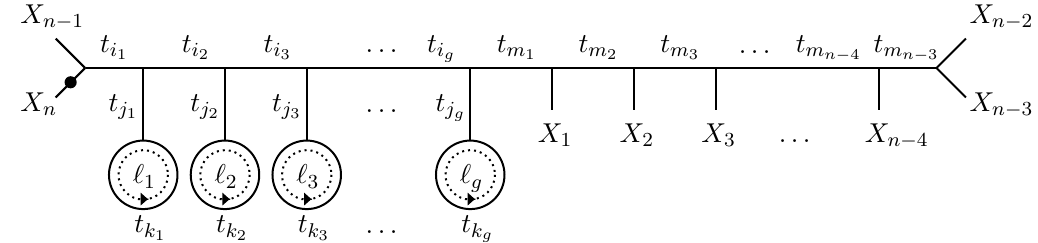
Figure 19. An example planar skeleton graph with g loops and n external edges. The large dot indicates our choice of base